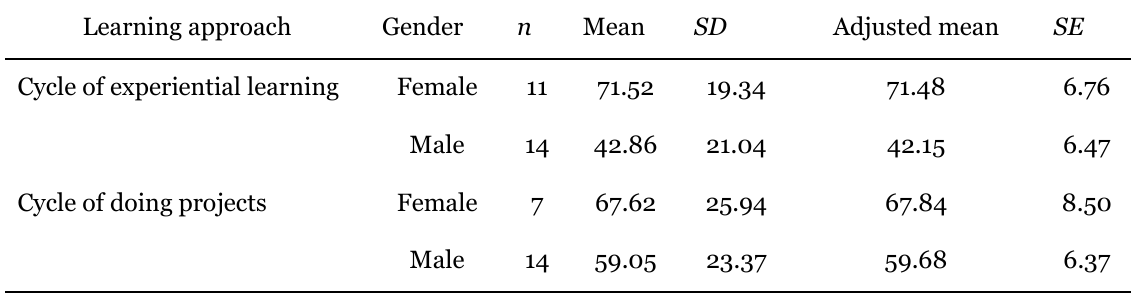
Simple Main-Effect Analysis Based on the Division of Learning Approaches Learning